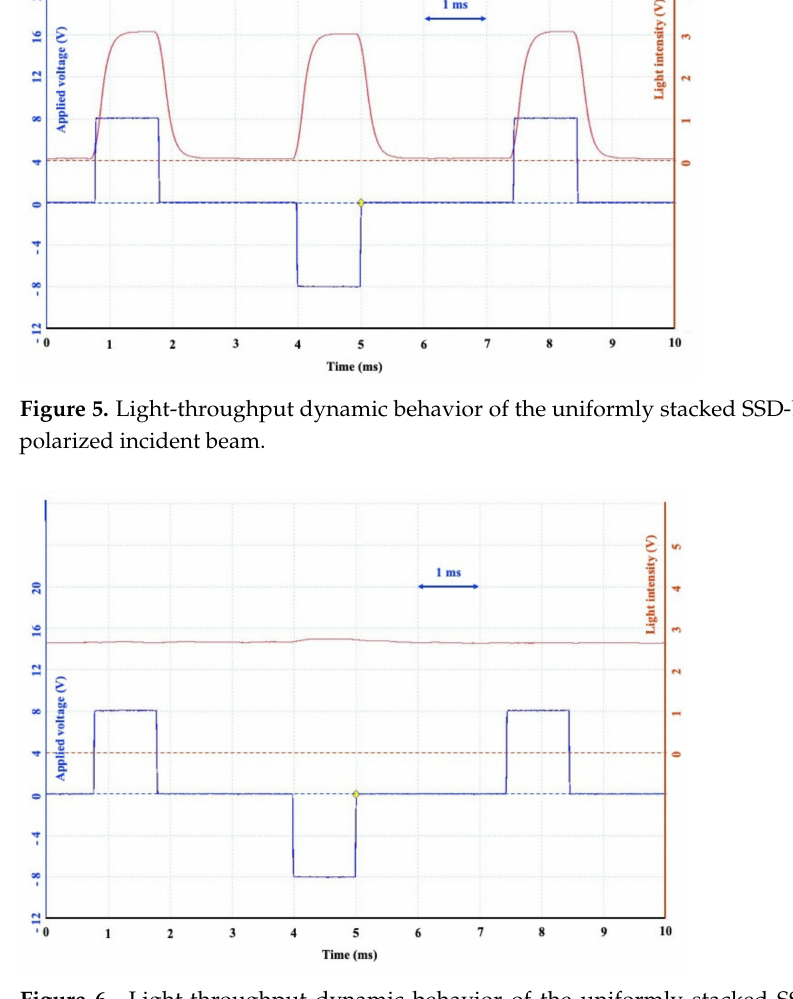
Figure 6. Light-throughput dynamic behavior of the uniformly stacked SSD-LC panel for the circularly polarized incident